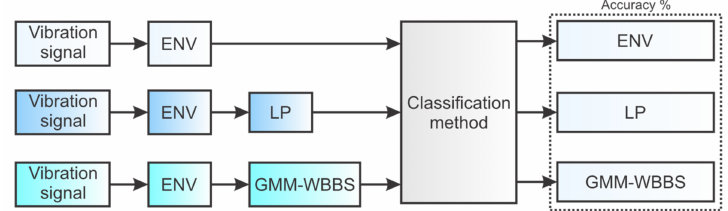
Figure 16. Method comparison